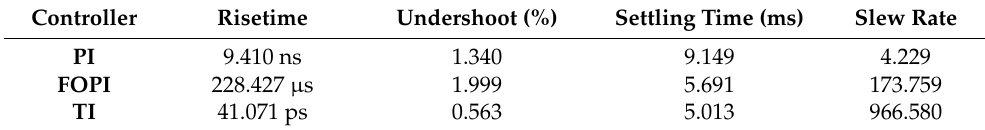
Figure 8. Control input performance of the PI, FOPI, and proposed TI controllers. Table 4. The dynamic performance parameter comparison for the PI, FOPI, and TI